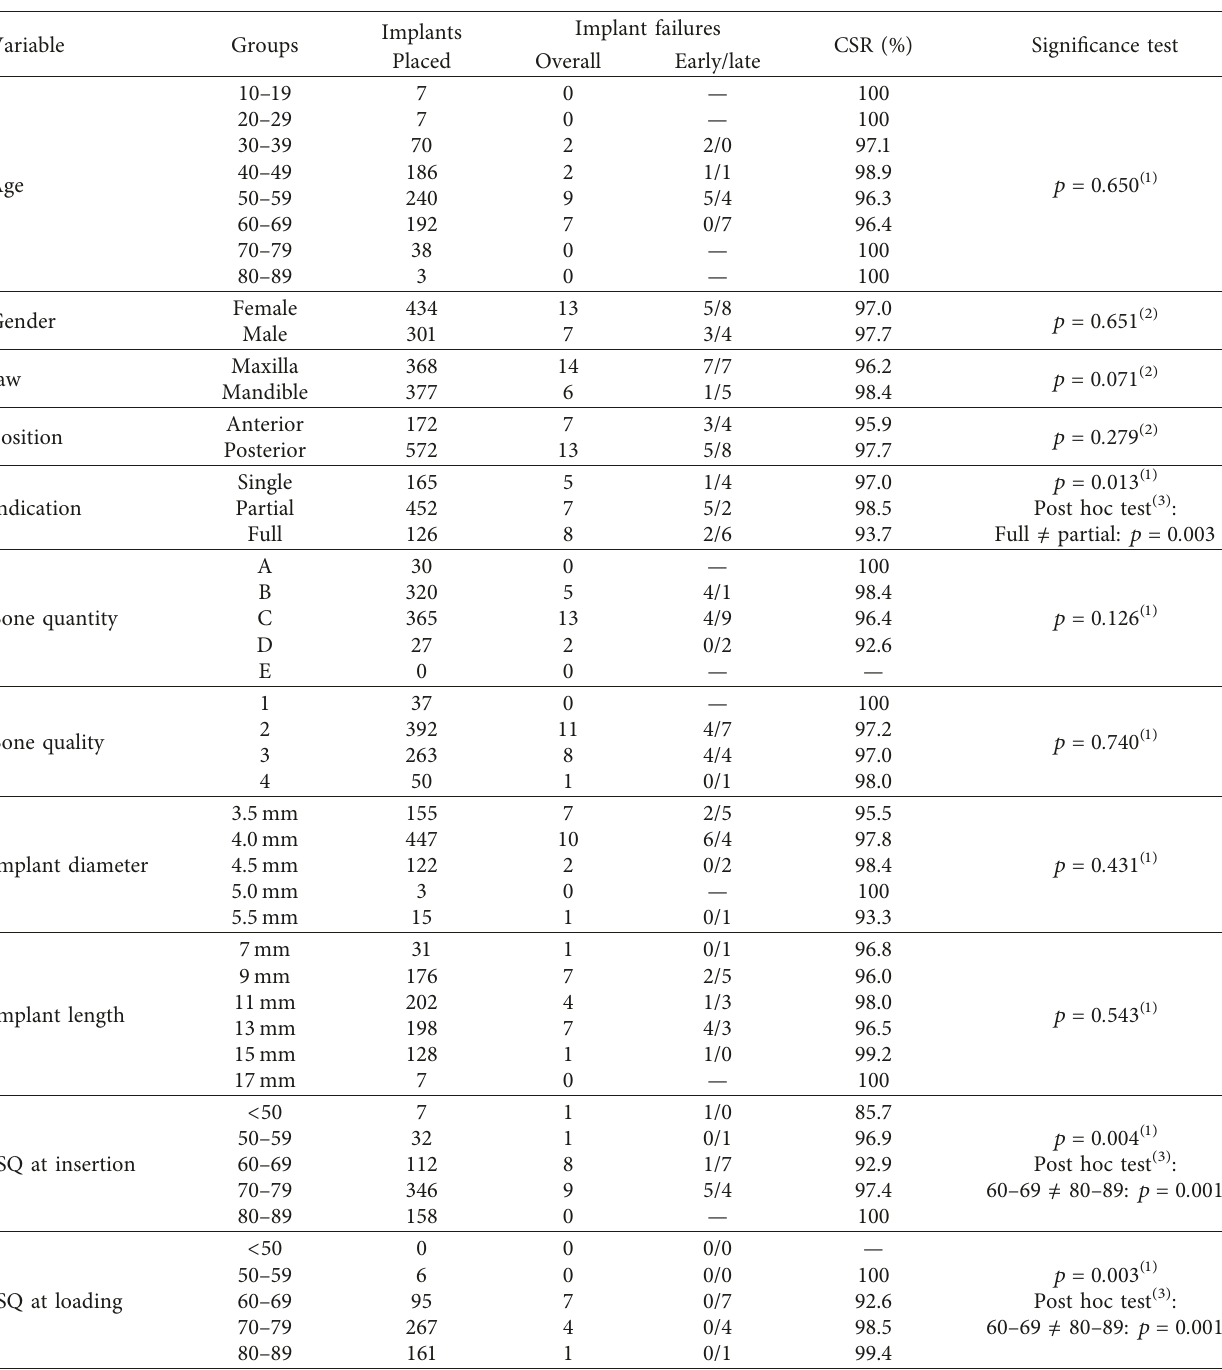
Table 9: Analyses of implant